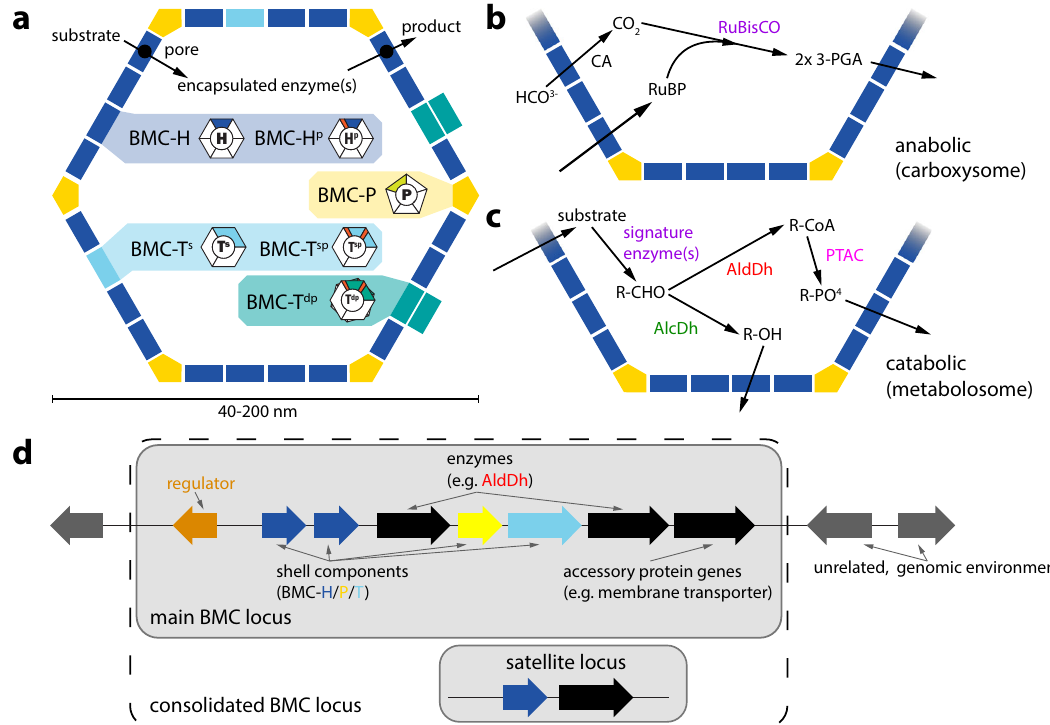
Fig. 1 Generalized BMC structure, function, and chromosomal organization of component genes. a Overview of a BMC shell and types of shell protein components. BMC-P: pentamer, pfam03319 domain (Supplementary Fig. 1a); BMC-H: hexamer, pfam00936 domain (Supplementary Fig. 1b); BMC-H p